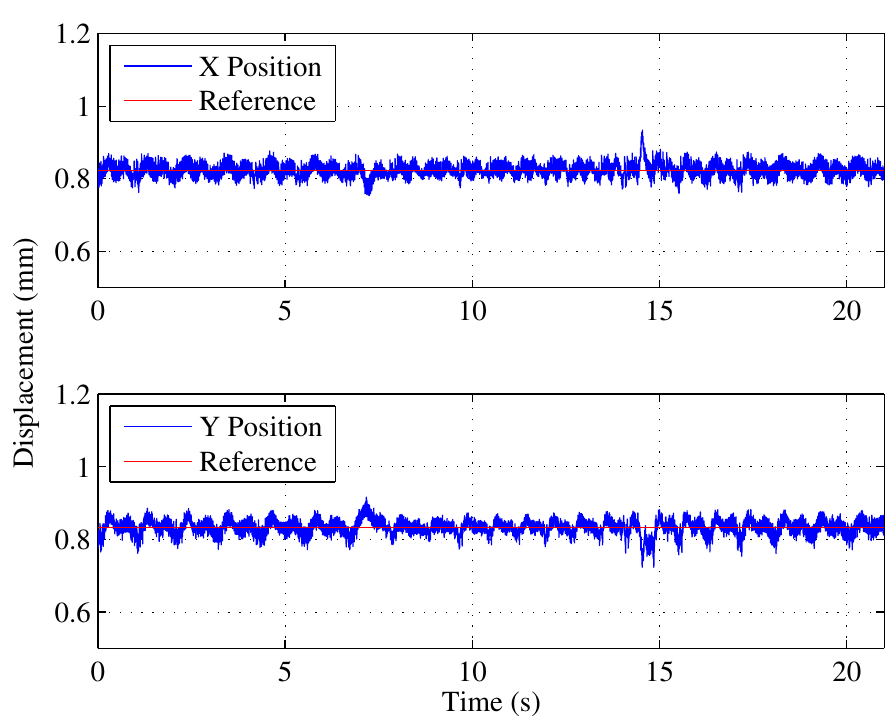
Figure 14. Two-phase system position response for load changes.